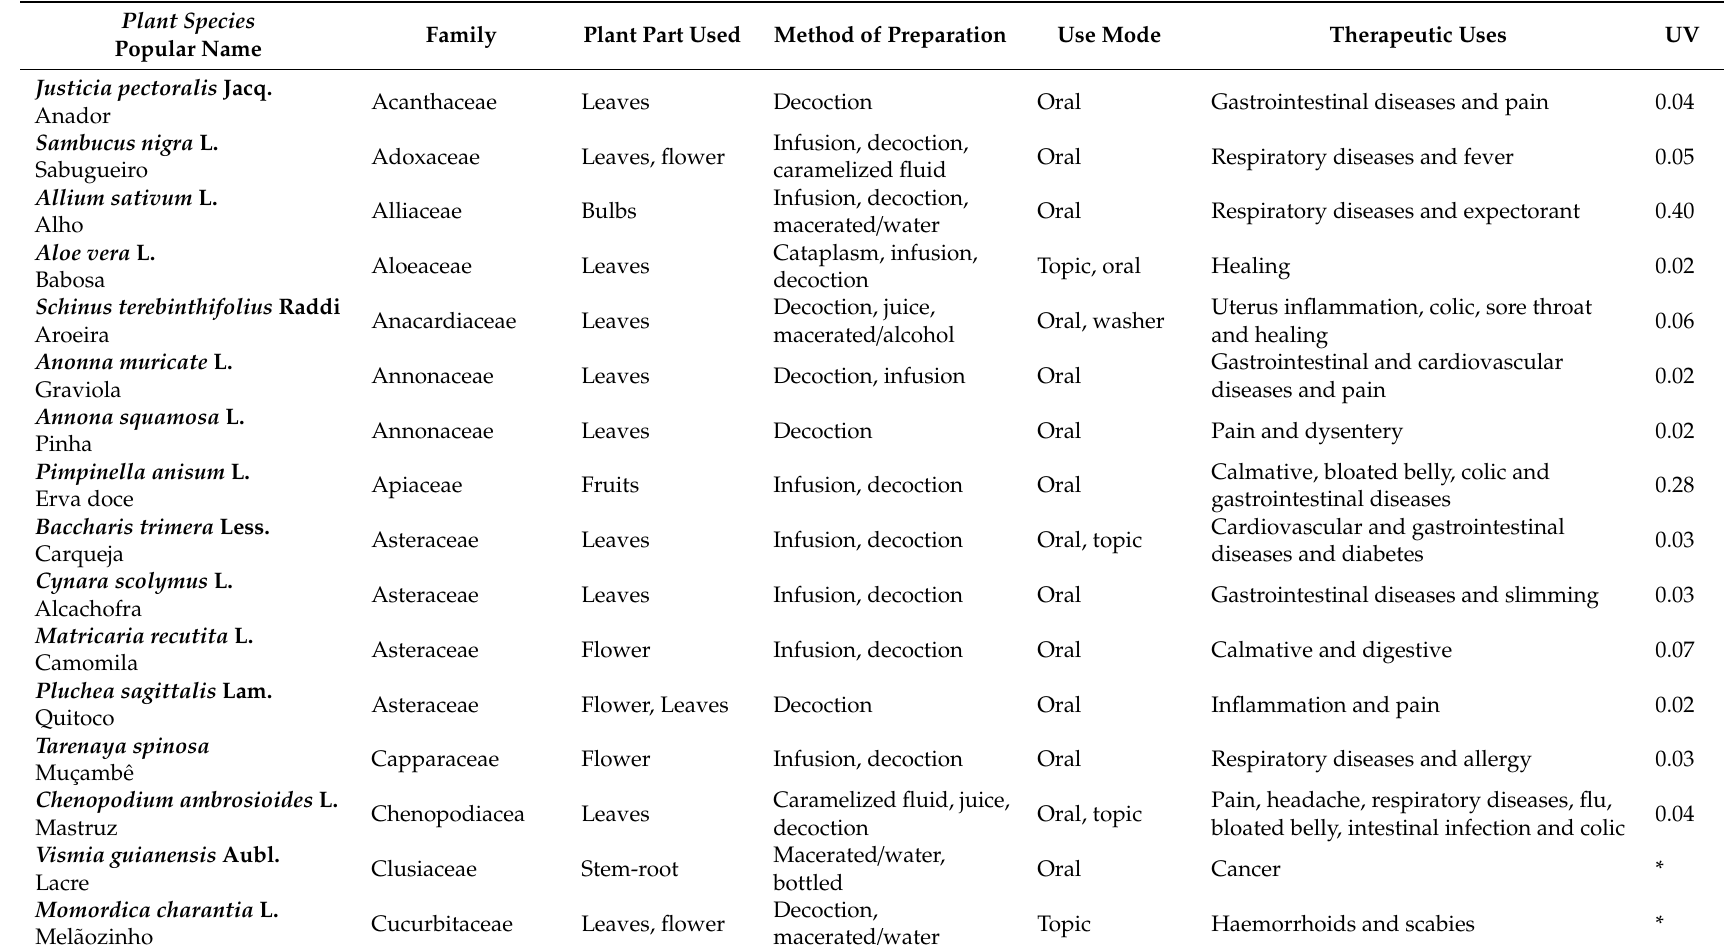
Table 2. Ethnomedicinal uses of plant species from Macei ó (Alagoas-Brazil). Plant